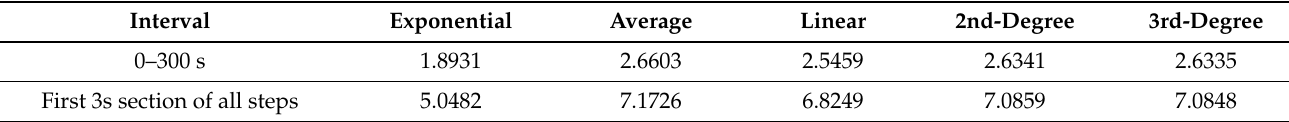
Table 9. Average absolute error for the different proposed